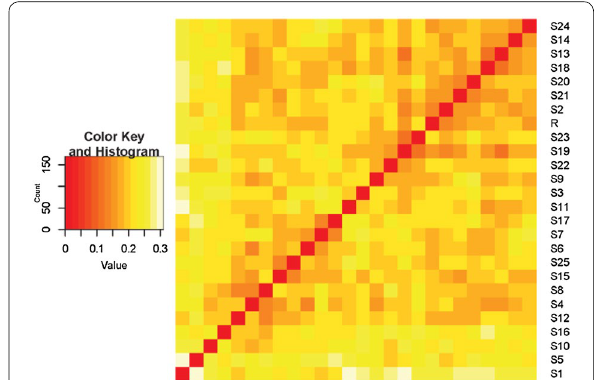
Figure 4 Thermal map of SIM